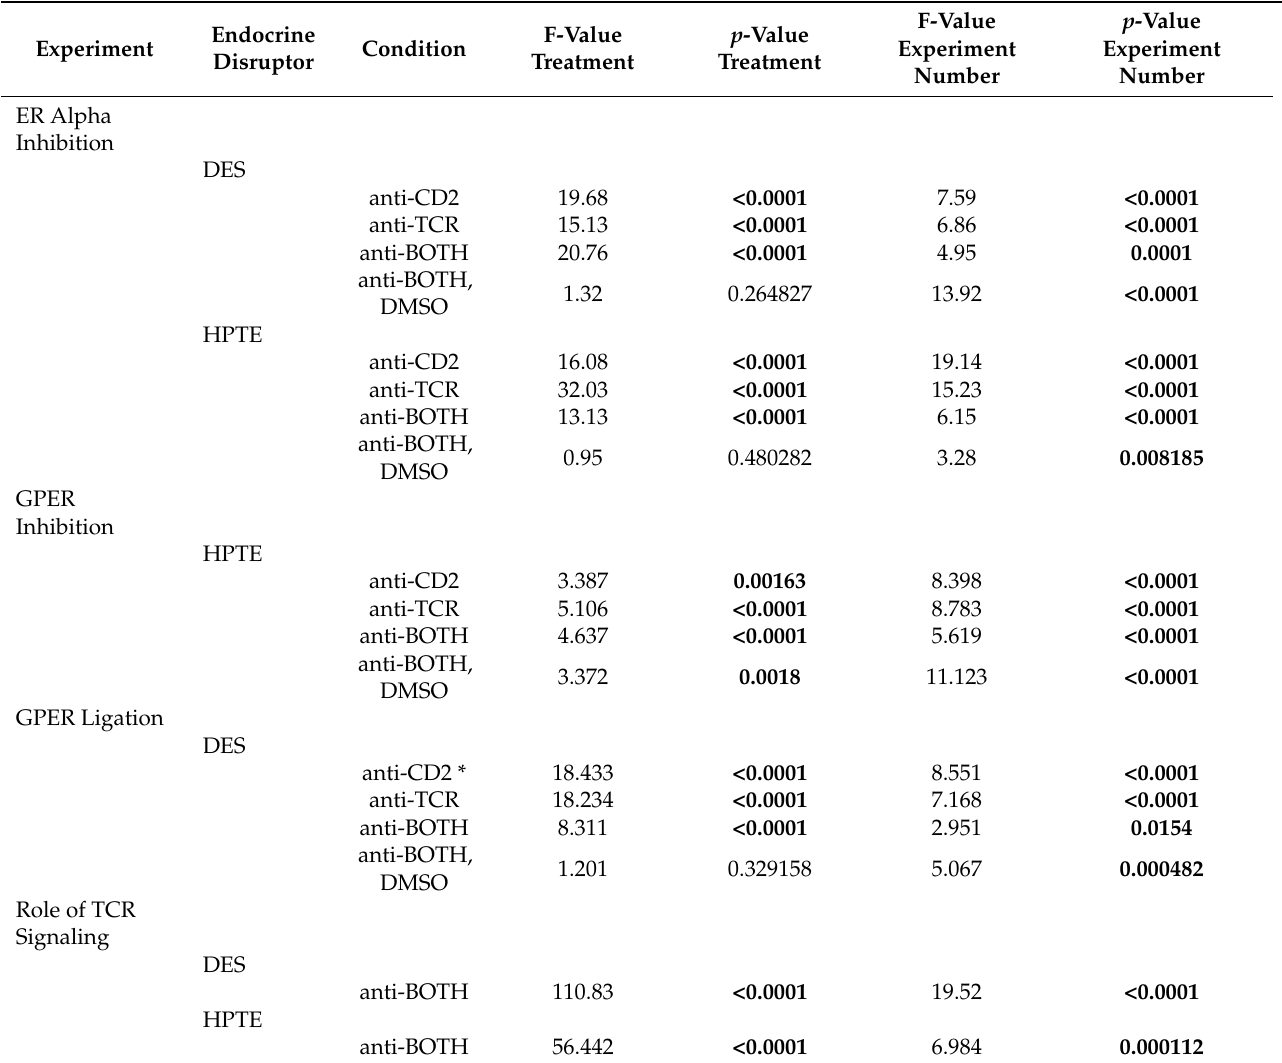
Table 1. Blocked 2-way ANOVA with total cell counts across treatments and